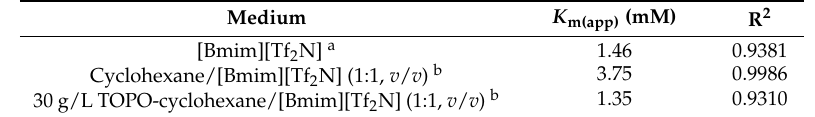
Table 2. Kinetic constants of the lipase-catalyzed synthesis of CAPE under different